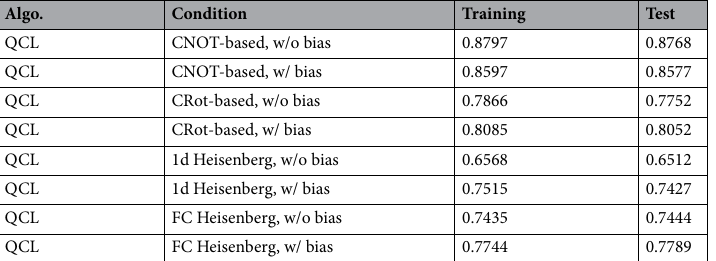
Table 2. Results of 5-fold CV with 5 different random seeds for the cancer dataset (0 or 1). The number of layers L is 5 and the number of iterations is 300. We consider four types of circuits with and without the bias term: the CNOT-based circuit, the CRot-based circuit, 1d Heisenberg circuit, and the FC Heisenberg circuit. As shown in Fig. 3, increasing the number of layers L does not lead to better performance, and can in fact decrease performance of QCL.